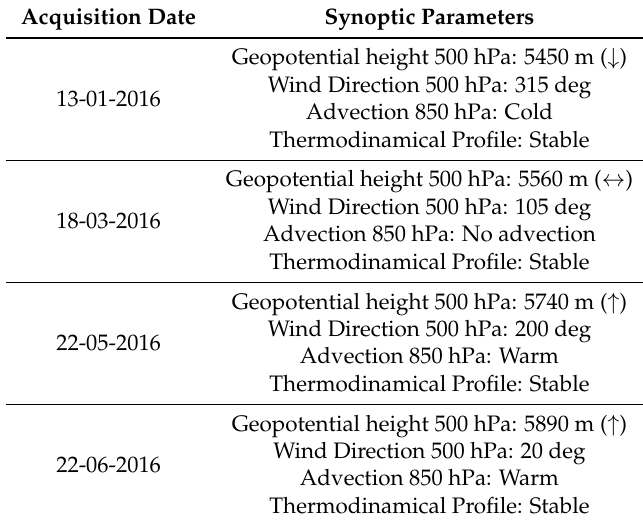
Table 2. Synoptic conditions at the acquisition dates of of the satellites [34,35]. Arrows for Geopotential height indicate decreasing ( ↓ ), steady ( ↔ ), and increasing ( ↑ )